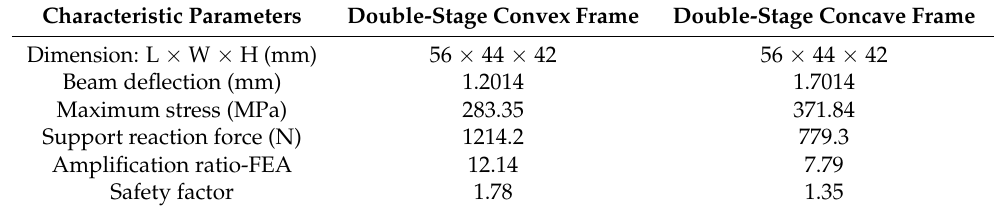
Table 3. Selected characteristic parameters and analytical results for different double-stage frames.